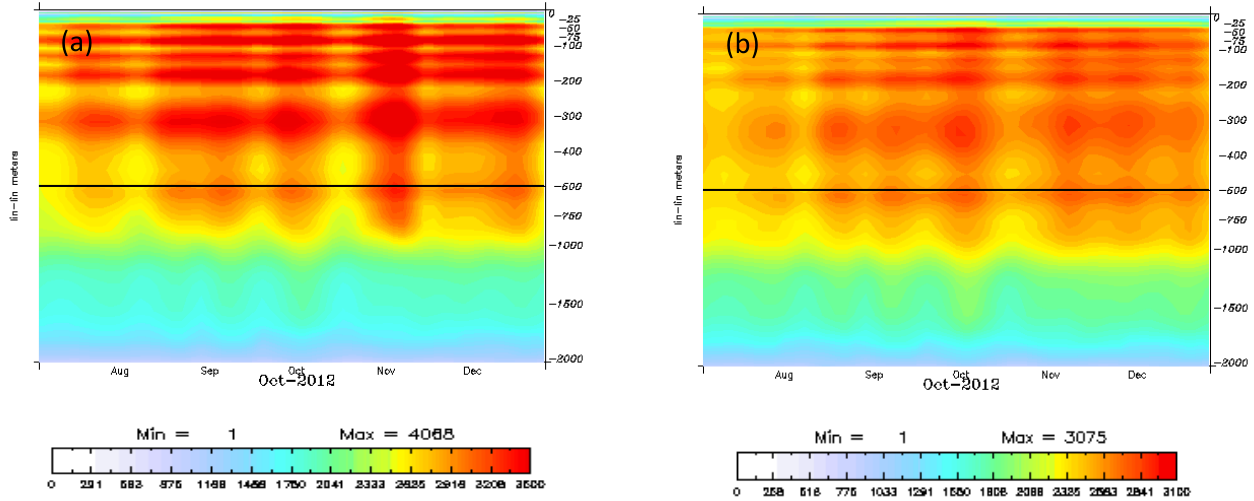
Figure 2. Time series of the number of 2012 in situ temperature (a) and salinity (b) data items from the surface to 2000m per week.